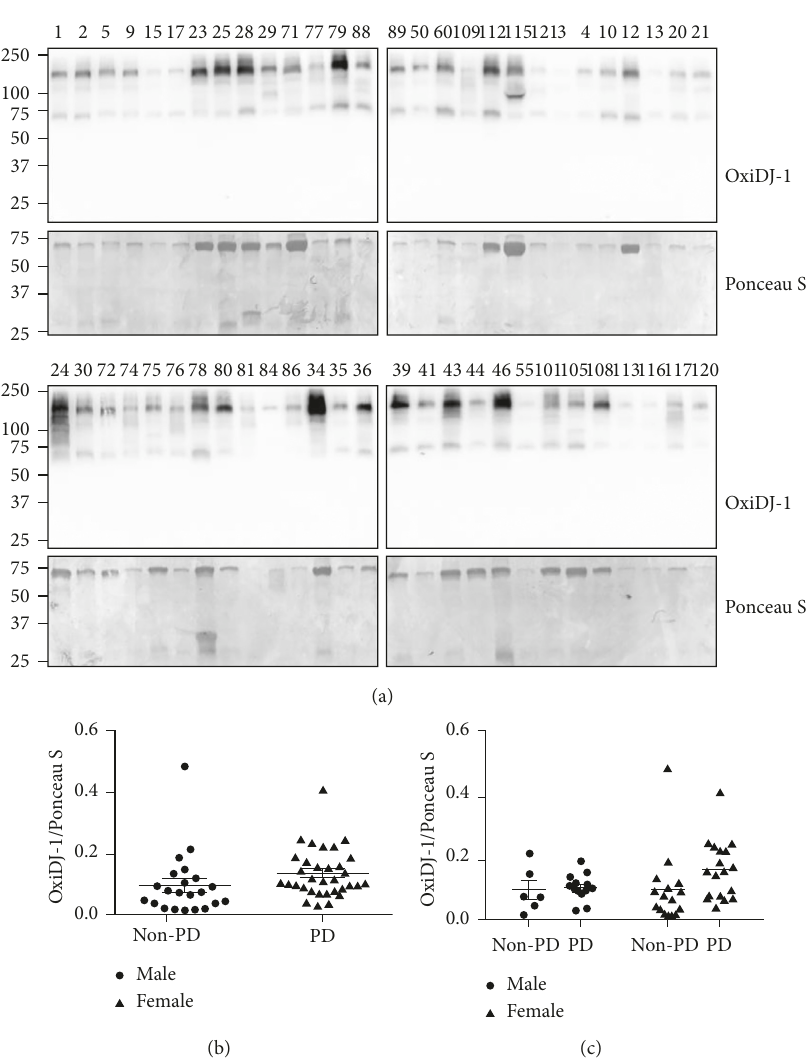
Figure 3: Comparison of OxiDJ-1 levels from patient urine samples using Western blot analysis. (a) Urine samples of non-PD controls (34, 35, 36, 39, 41, 43, 44, 46, 50, 55, 60, 101, 105, 108, 109, 112, 113, 115, 116, 117, 120, and 121) or PD patient (1, 2, 3, 4, 5, 9, 10, 12, 13, 15, 17, 20, 21, 23, 24, 25, 28, 29, 30, 71, 72, 74, 75, 76, 77, 78, 79, 80, 81, 84, 86, 88, and 89) were subjected to Western blot. The numbers at the top of the images are the patient numbers. (b) OxiDJ-1 levels were normalized with total protein levels determined by Ponceau S staining, and their ratio was diagramed. Student’s t -test was used for this analysis. (c) Gender-grouped OxiDJ-1 levels were analyzed. All comparisons with one- way ANOVA were not